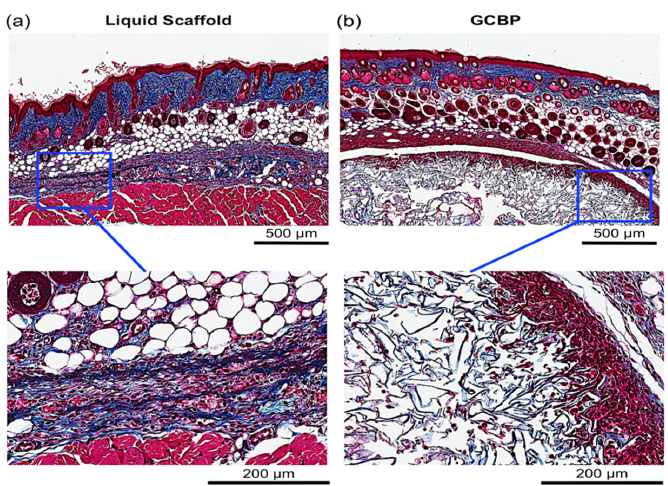
Figure 3. Histological evaluation after 2 weeks with MT staining. ( a ) Higher magnification of Liquid Scaffold shows denser blue staining compared to week 1. ( b ) Higher magnification of GCBP displays a persisting layer of highly cellular capsule surrounding the matrix, with continued limited cellular